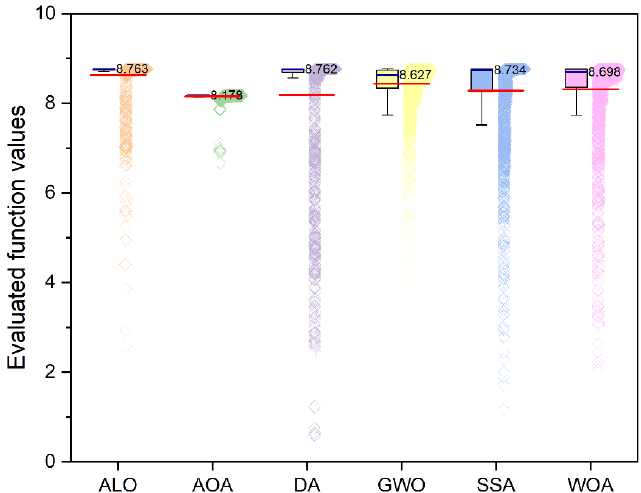
Figure 2. Box plots denoting the spread of all function evaluations during MRR optimization in a typical independent run. The horizontal blue line (and numeric value) and the red line indicate the median and mean of all the function evaluations.